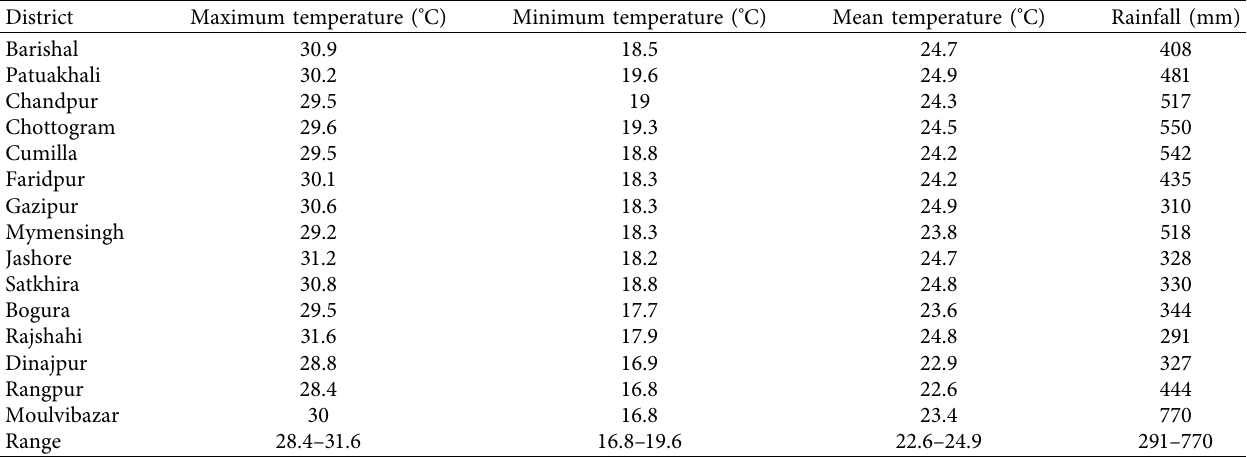
Figure 1: Study locations in Table 1: Seasonal (December–May) normal weather (1981–2016) of the study locations.